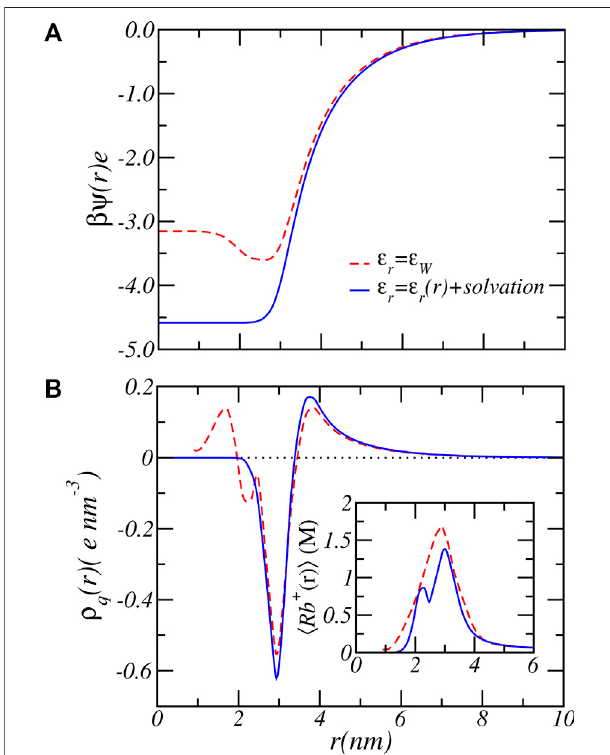
FIGURE 8 | The electrostatic potential (A) and total charge number density (B) asfunctionofradialcoordinatefor fi xeddielectricconstant(dashed lines) and varying dielectric constant plus electrostatic solvation energy (solid lines). The inset shows the total Rb + ion concentration including free and bound ions. The reservoir has a pH value of 7.4 and a RbCl concentration of [RbCl] = 50